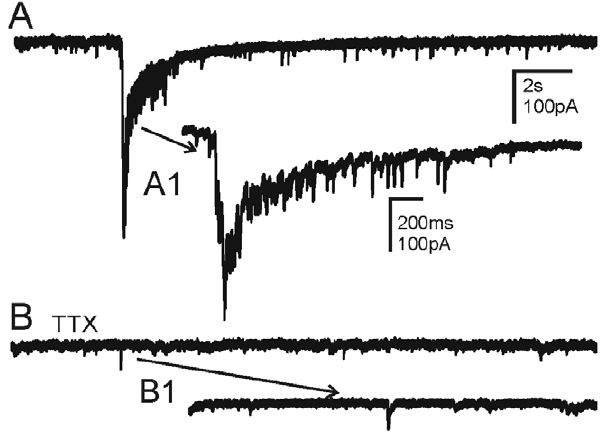
Figure 3. Action potential dependence of epileptiform EPSC bursts. A . Spontaneous burst activity recorded from a granule cell in a pilocarpine-treated mouse that survived SE. B . The bursts were completely blocked by TTX (1 m M), indicating they were action potential-dependent. Action potential-independent mEPSCs were still seen in the presence of TTX. A1 and B1 are expanded segments of A and B respectively. The recordings were made in the absence of Mg 2 + and presence of bicuculline (30 m M).